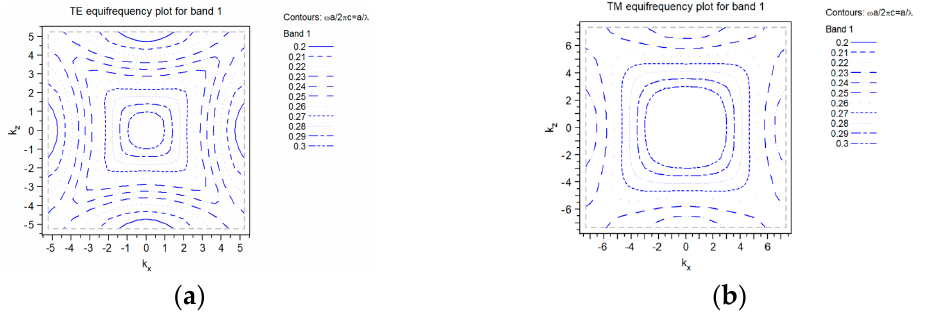
Figure 2. ( a ) EFC diagram in TE mode; ( b ) EFC diagram in TM mode.